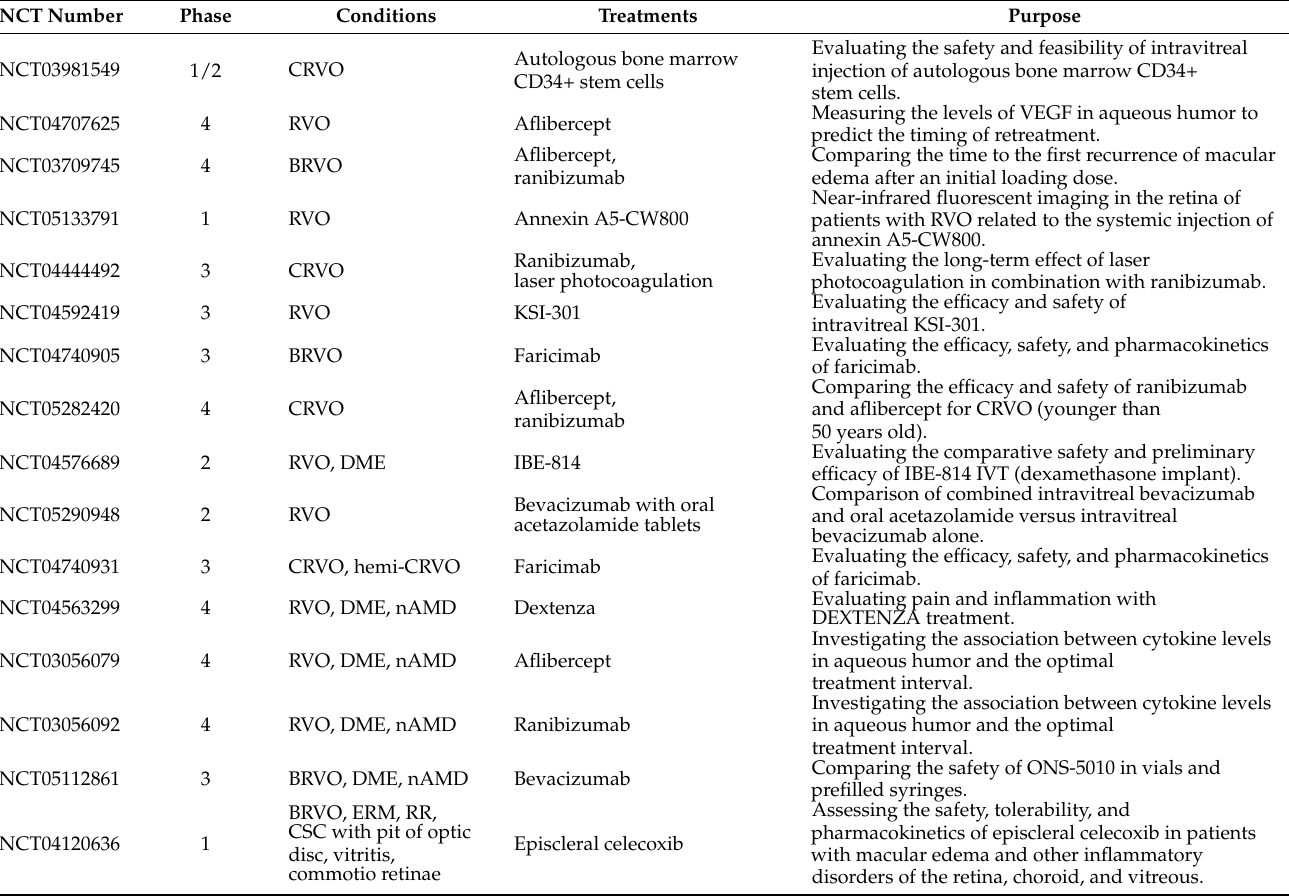
Table 2. Ongoing Phase I–IV clinical trials for retinal vein